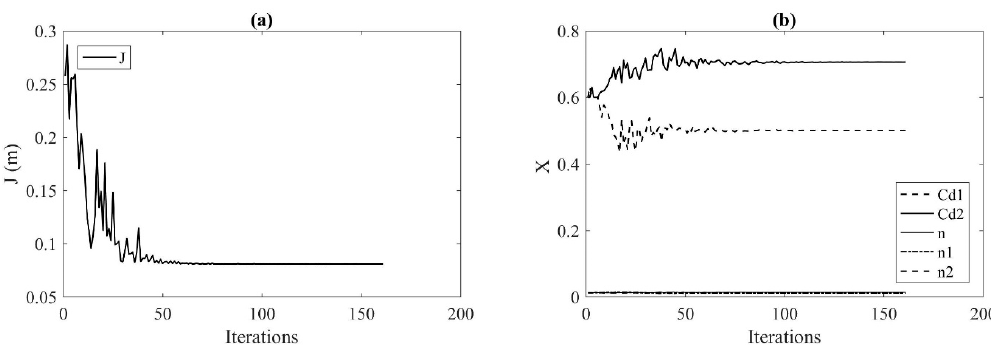
Figure 3. For 2015, the values of J ( a ) and of the parameterized hydraulic variables contained in the vector X ( b ) during the iterations of the optimization process that resulted in the minimization of the criterion.